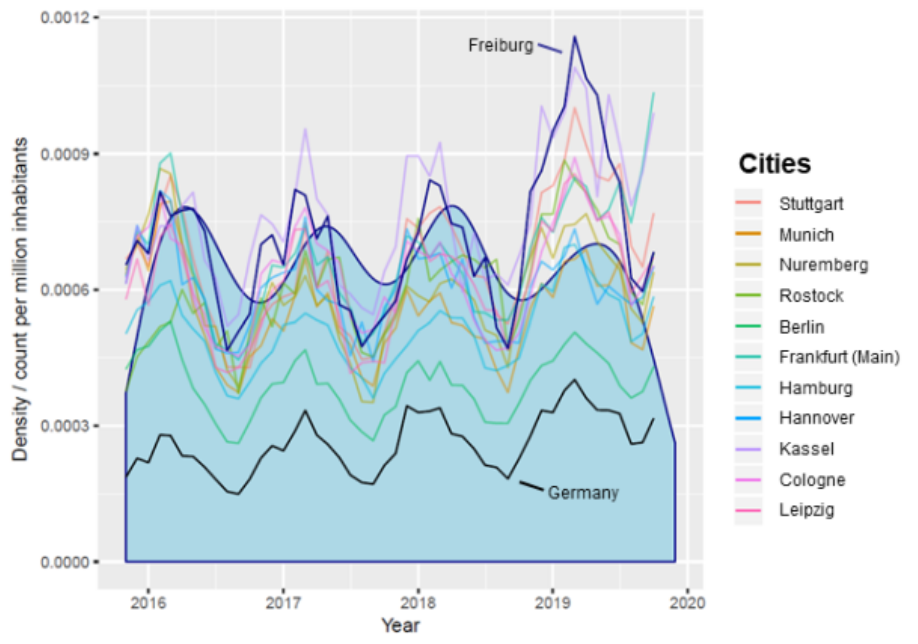
Figure 2. Density plot. Patients diagnosed with conjunctivitis (ICD code group "H10.-") in the centralized ophthalmologic emergency practice for the Freiburg region (light blue) superimposed with normalized cumulative Google search frequencies of all 714 terms for conjunctivitis. All curves show the same recurrent seasonal trend.